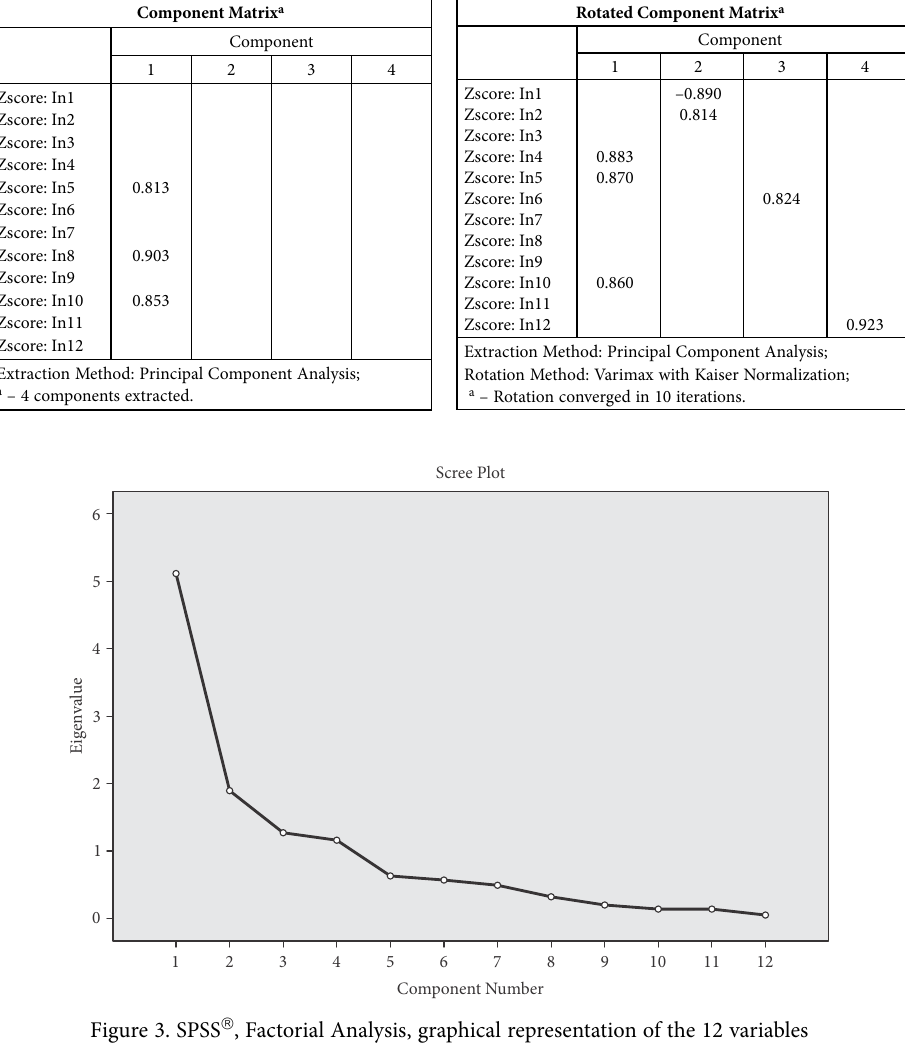
Figure 3. SPSS  , Factorial Analysis, graphical representation of the 12 variables